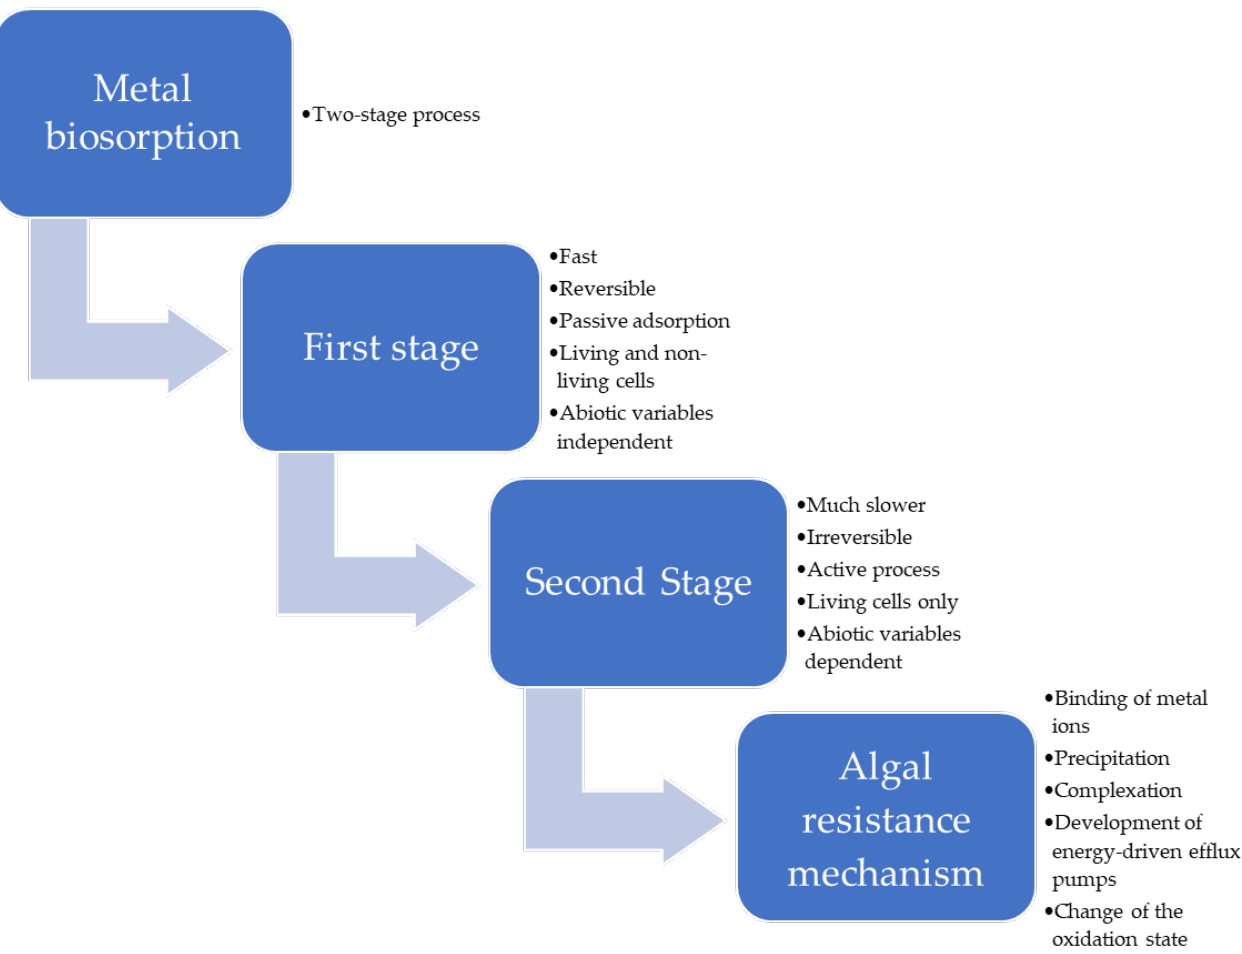
Figure 2. Metal biosorption by microalgae.